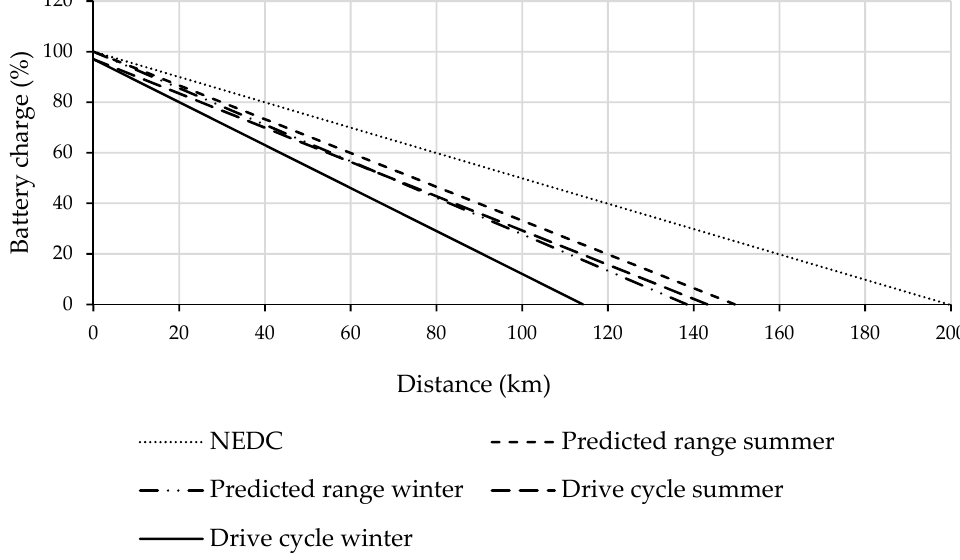
Figure 11. Discharge comparison for extra-urban route.